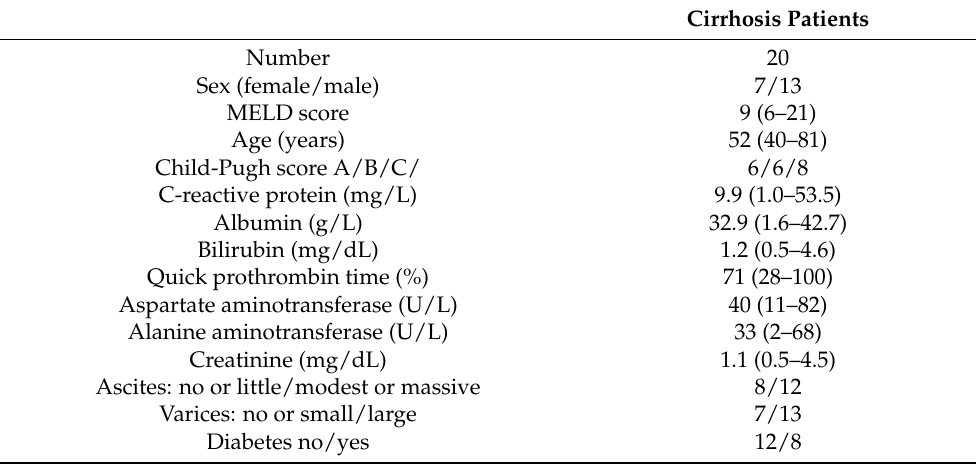
Table 1. Patient demographics and laboratory parameters (median values and ranges are shown).